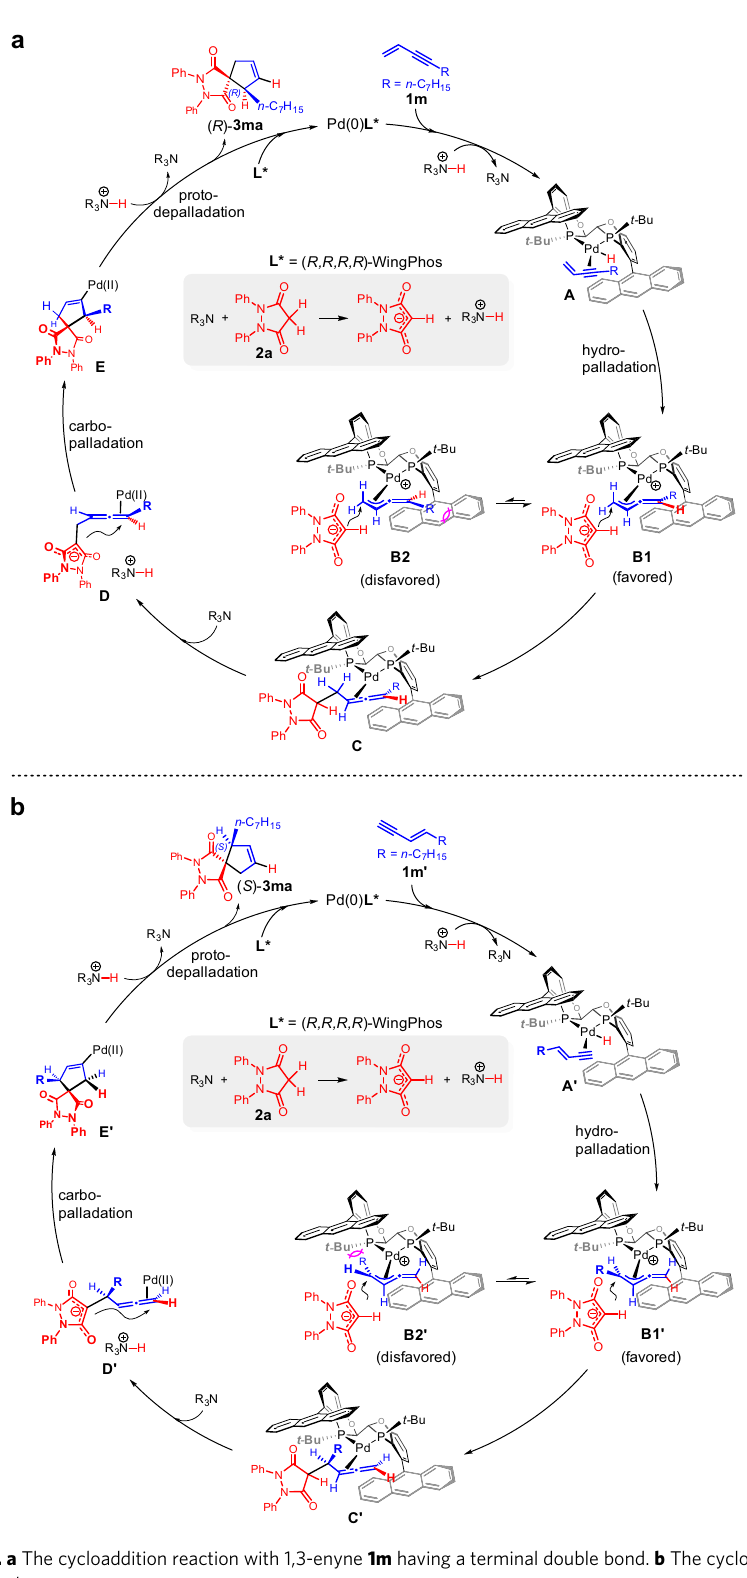
Fig. 7 Proposed catalytic cycle. a The cycloaddition reaction with 1,3-enyne 1m having a terminal double bond. b The cycloaddition reaction with 1,3-enyne 1m ′ having a terminal triple